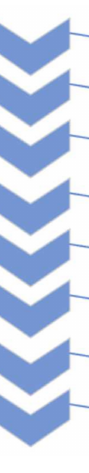
Figure 2. The final ranking of the best vehicles to implement in the car-sharing